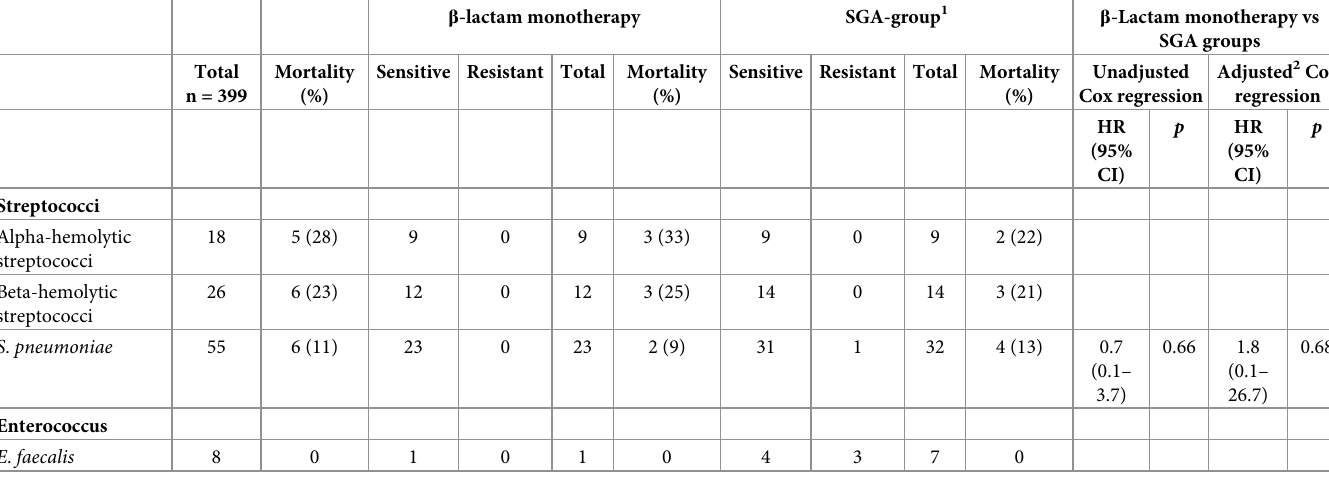
the unadjusted HR was 3.4 (95% CI 1.1–10.4), p = 0.036 and adjusted HR 4.4 (95% CI 1.3– 15.1), p = 0.019. Among patients with unknown focus of infection unadjusted HR was 2.0 (95% CI 1.1–3.6), p = 0.023 and adjusted HR 3.4 (95% CI 1.8–6.6), p < 0.001. Different bacteria and mortality Bacterial agents in blood cultures were grouped as shown in Table 2. Most common pathogens were E . coli (22%), followed by S . aureus (21%) and S . pneumoniae (16%). For further details, see supplement 1 in S1 File. Patients with infections caused by E . coli and S . aureus showed a Table 2. Microbiology findings in blood cultures, susceptibility to administered antibiotic regime and 28-day mortality. β -lactam monotherapy SGA-group 1 β -Lactam monotherapy vs SGA groups Total Mortality Sensitive Resistant Total Mortality Sensitive Resistant Total Mortality n = 399 (%) (%)